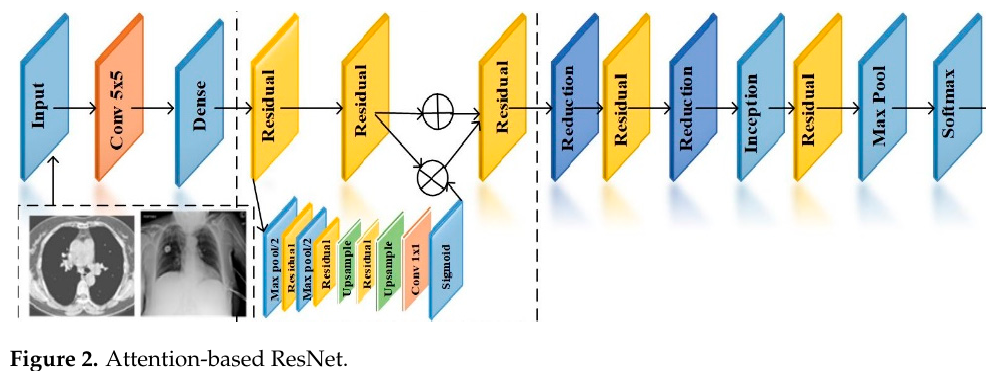
Figure 2. Attention-based